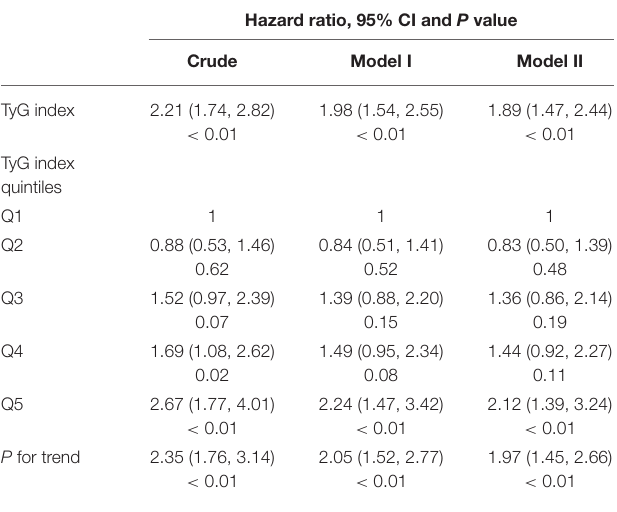
TABLE 2 | Multivariate analysis for the relationship between TyG index and incident